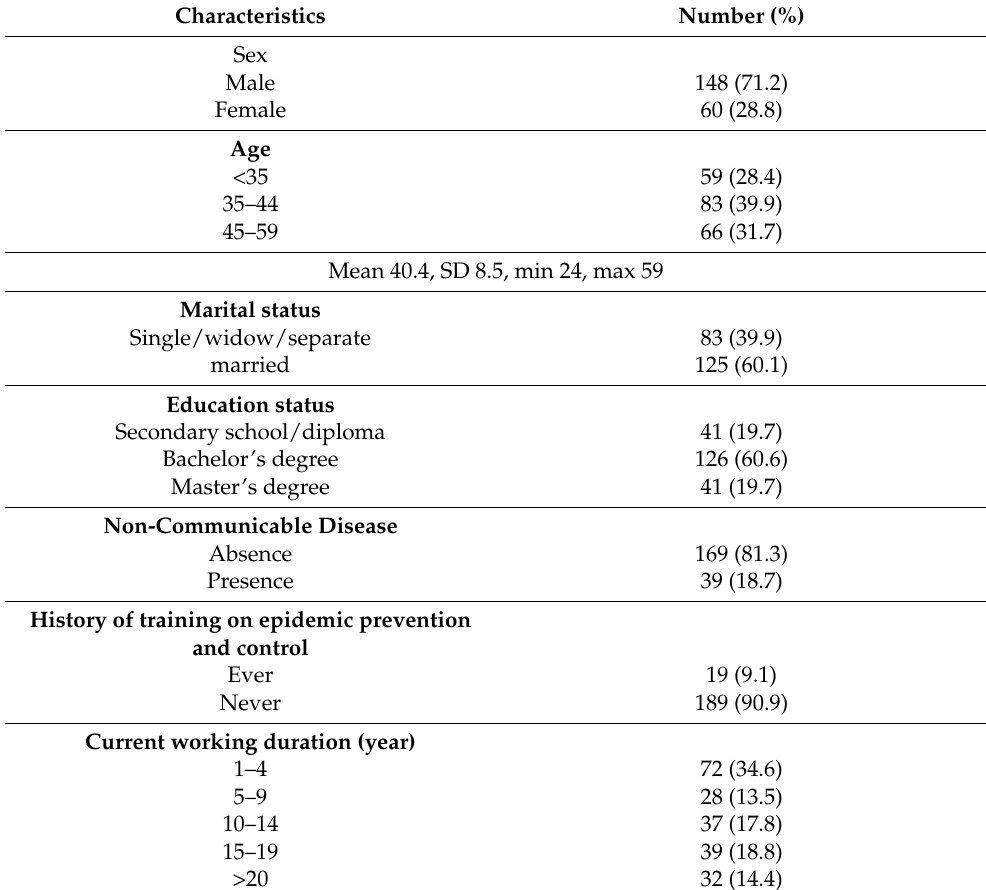
Table 1. Characteristics of participants ( n = 208).